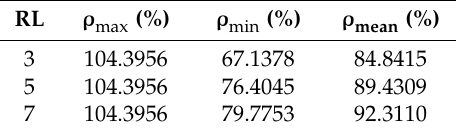
Table 2. Average performance results with three different reliability limit (RL) values.